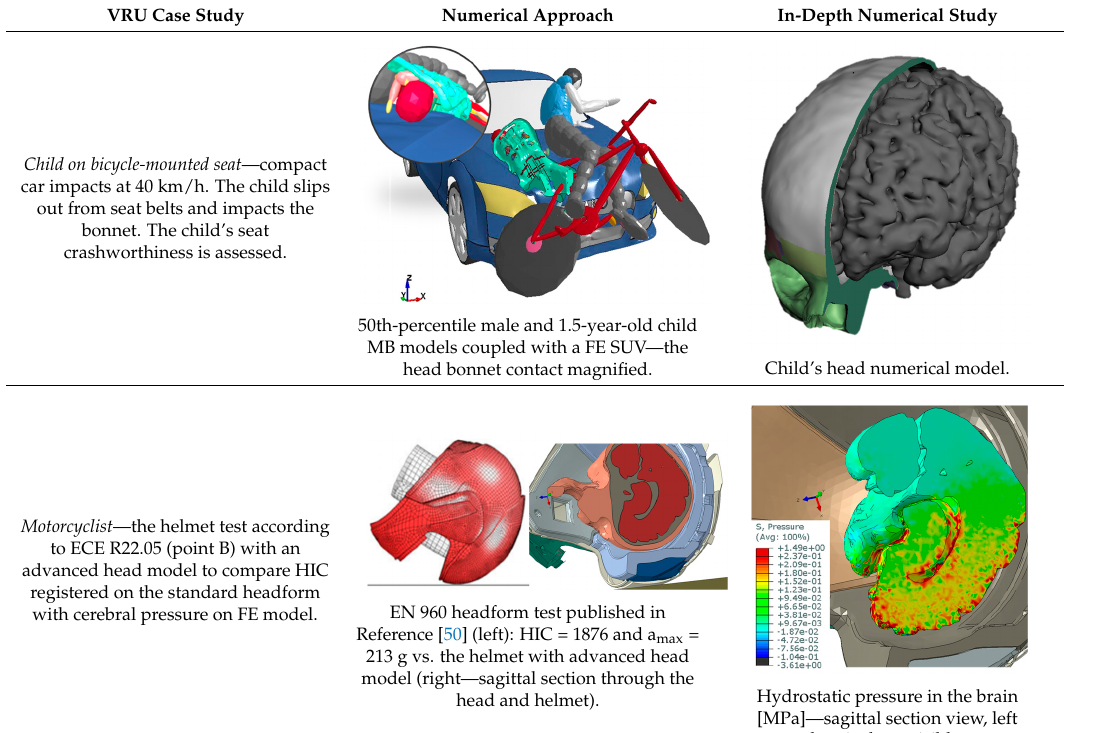
Motorcyclist —the helmet test according to ECE R22.05 (point B) with an advanced head model to compare HIC registered on the standard headform with cerebral pressure on FE